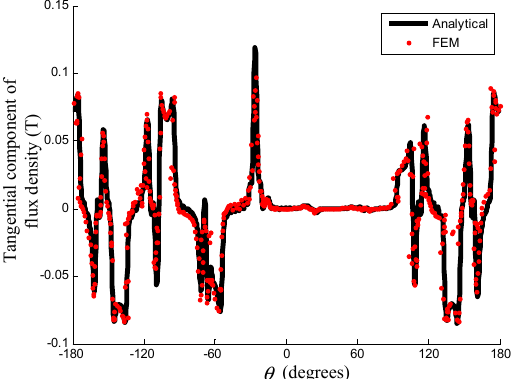
Figure 9. Tangential magnetic flux density due to just armature winding in the middle of the air-gap, when the current density of phase A is zero, current density of phase B is 4.33 A/mm 2 and phase C is 4.33 A/mm 2 .